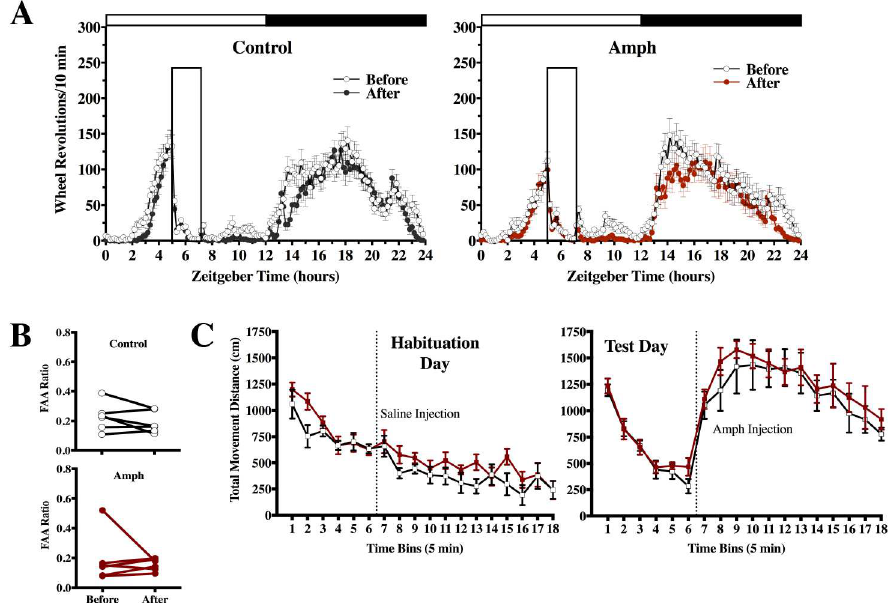
Fig 5. Exp 2: measuring FAA to RF before and after AMPH sensitization compared to non-handled controls, within group design. Home-cageactivity expressedin wheelrevolutions/10 min +/- SEM before and after AMPH sensitization for AMPH-pretreated and non-handled controls, closed box indicatesfeeding window( A ). FAA ratios +/- SEM expressedas individualrat FAA ratios duringRF-before and RF-after ( B) . AMPH-pretreated rats and non-handled controls injectedwith saline on habituationday and AMPH on test day, with open-field activity measuredas total movement distance+/-SEM in 5 min bins ( C ).